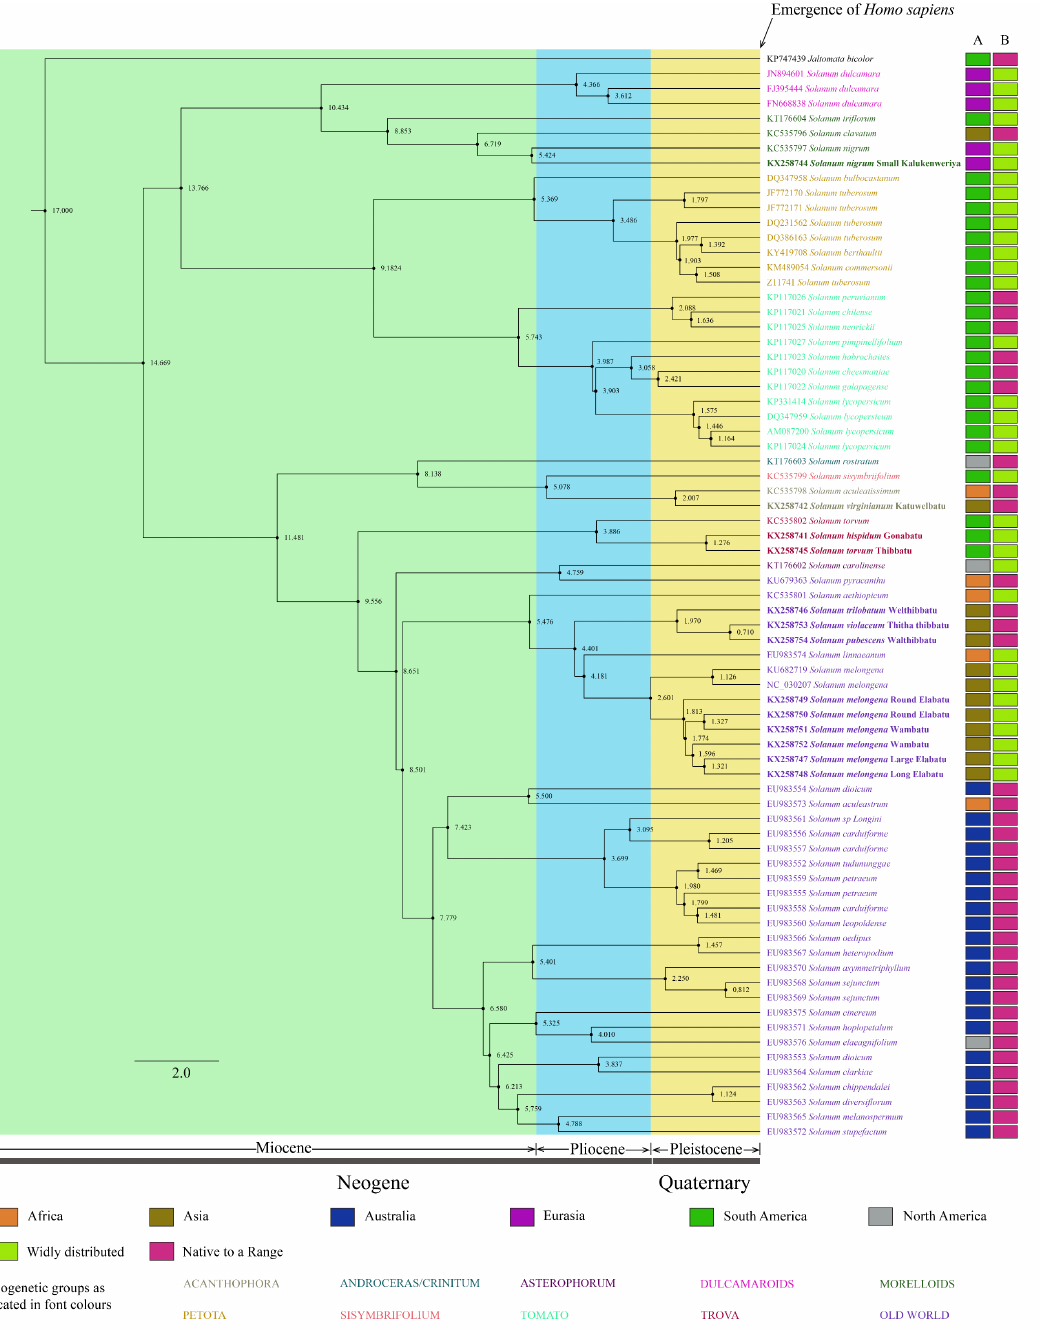
Figure 2 : The Maximum Clade Credibility Tree (MCC) showing the divergence time and geographic distribution of tips (operational taxonomic units). The geological time periods parallel to our divergence dating are given below the tree and tree is colored respectively. The color key below the tree indicates the native range (A) and the current state of distribution (B) of the respective Solanum spp. in the world. The nodes of the tree are labeled with the divergence time (in Million years ago). The Operational Taxonomic Units of Sri Lankan Solanum spp. are indicated in bold